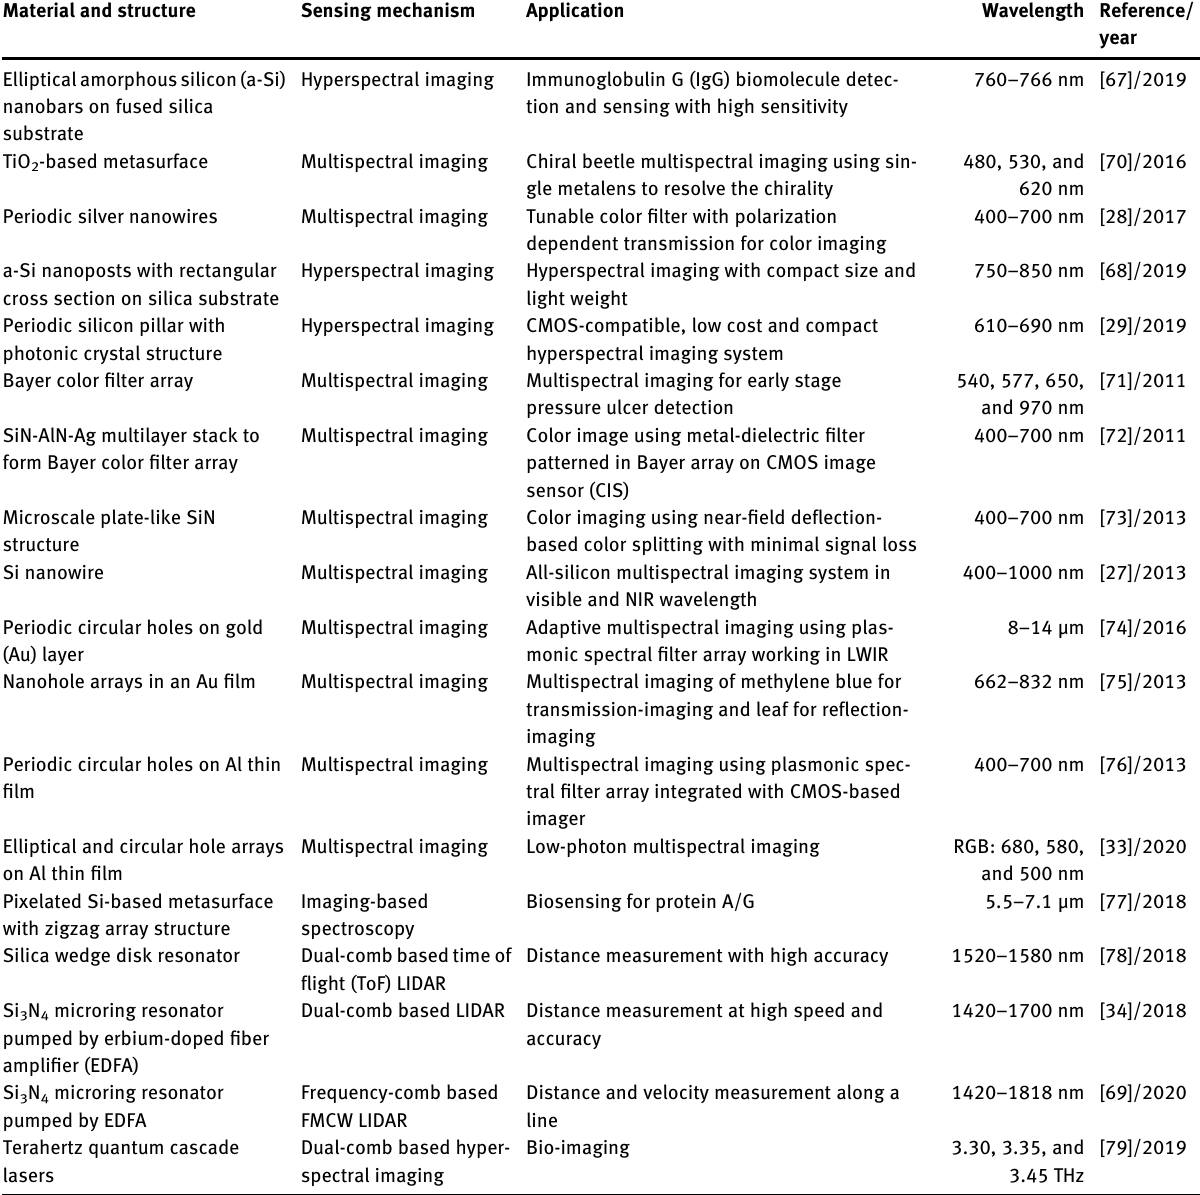
Table  : Summary of nanophotonics-based spectral imaging and LIDAR sensing systems. Material and